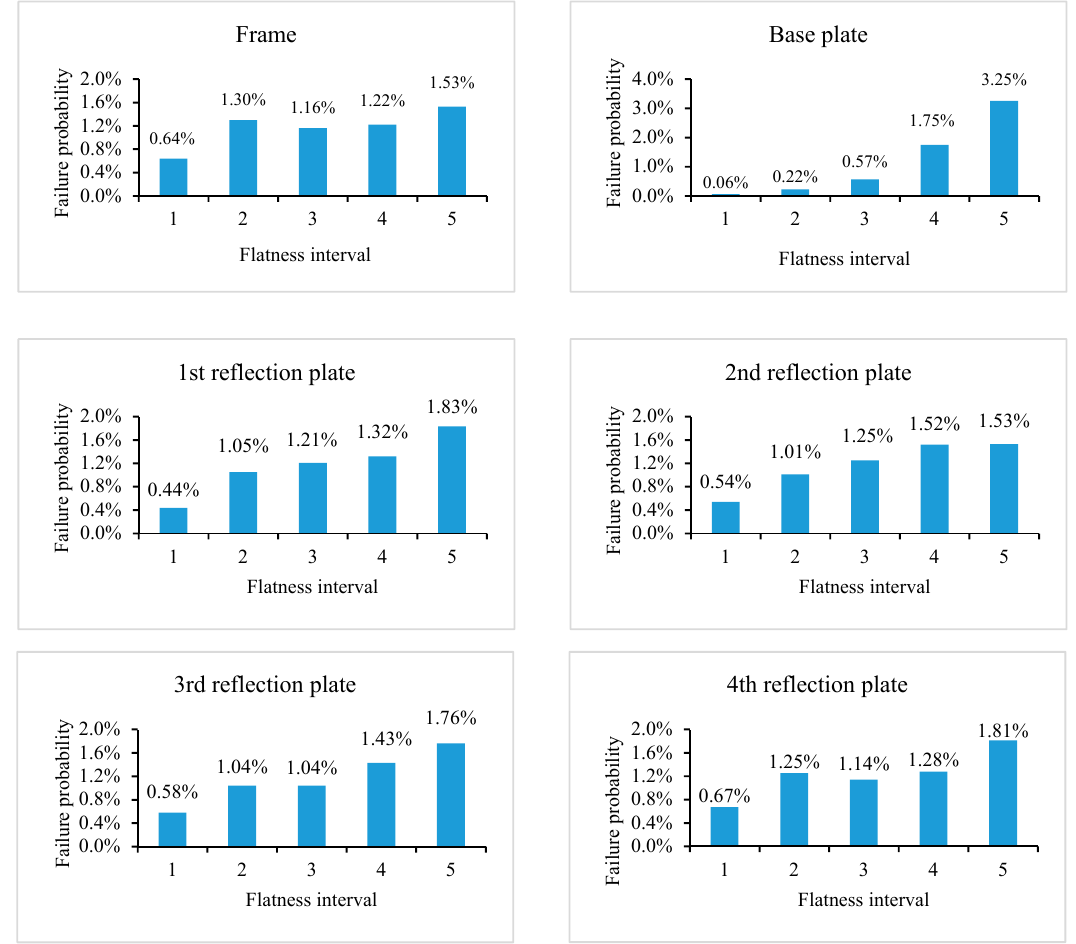
Figure 10. The failure probability of each interval of the tolerances.